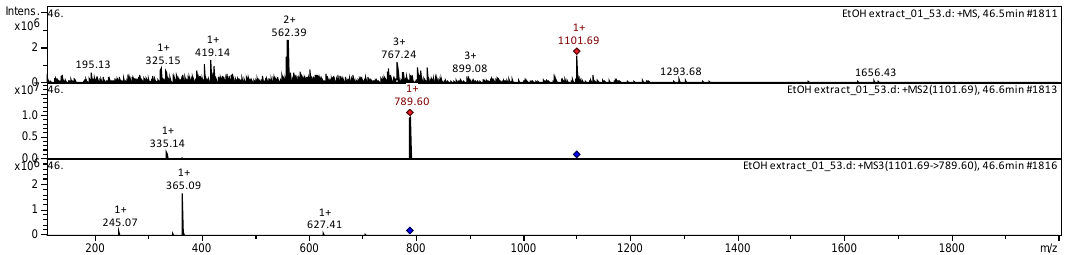
Figure 10. CID spectrum of the ginsenoside Rb2 from wild ginseng (Russia), m / z 1101.69. The molecular masses of the target analytes presented in the supercritical extract of wild ginseng P. ginseng (Russia) and analyzed by HPLC with tandem mass spectrometry are listed in Table 1 for easy identification. Table 1. Components identified from the supercritical extract of P. ginseng (Russia).